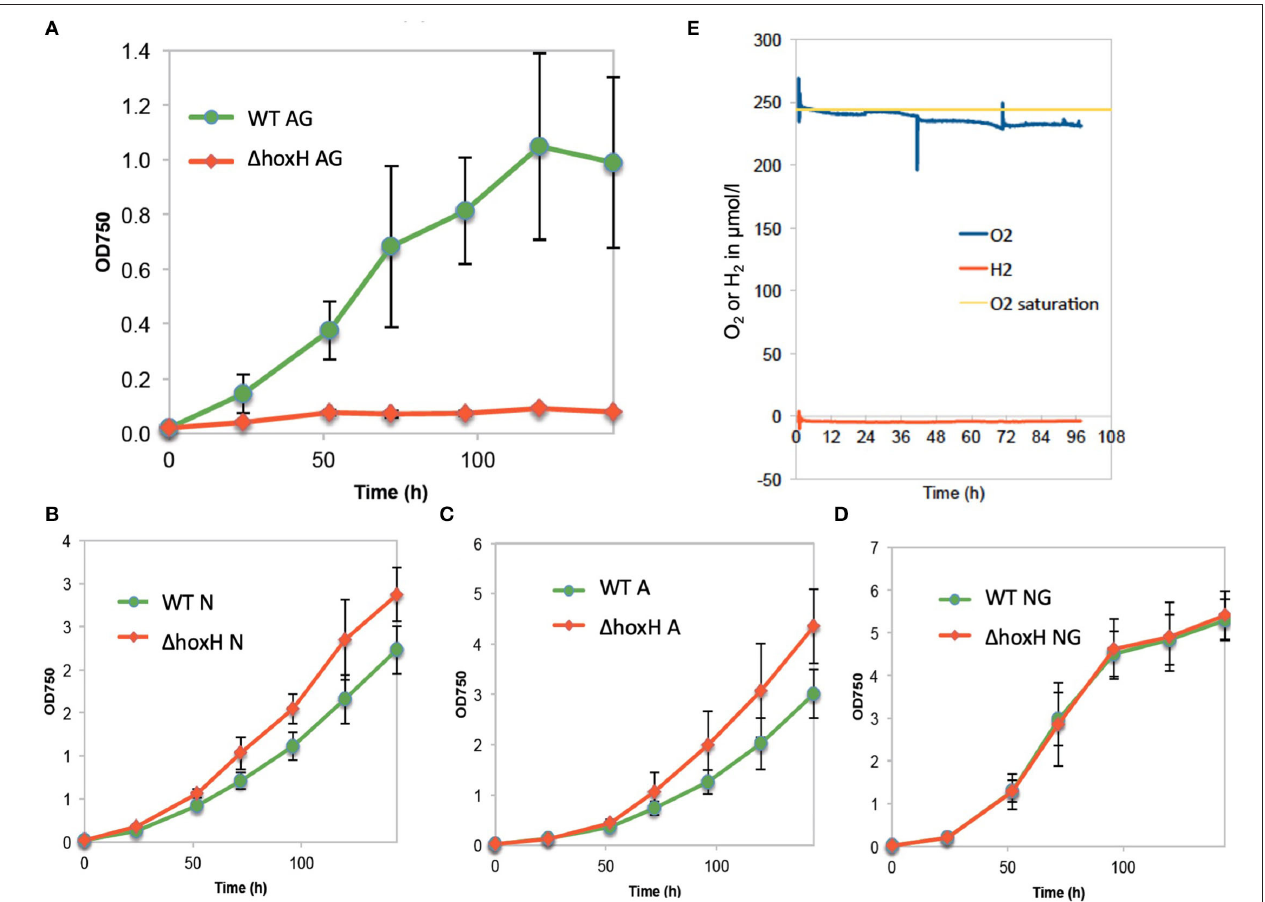
FIGURE 1 | Growth of wild type (WT) and 1 hoxH under different conditions and oxygen and hydrogen concentrations in cultures on arginine and glucose in continuous light (60 µ E/m2/s). (A) Growth in arginine and glucose (AG), (B) growth in nitrate (N), (C) growth in arginine (A), (D) growth in nitrate and glucose (NG), (E) O 2 and H 2 concentration in the cultures cultivated on arginine and glucose.